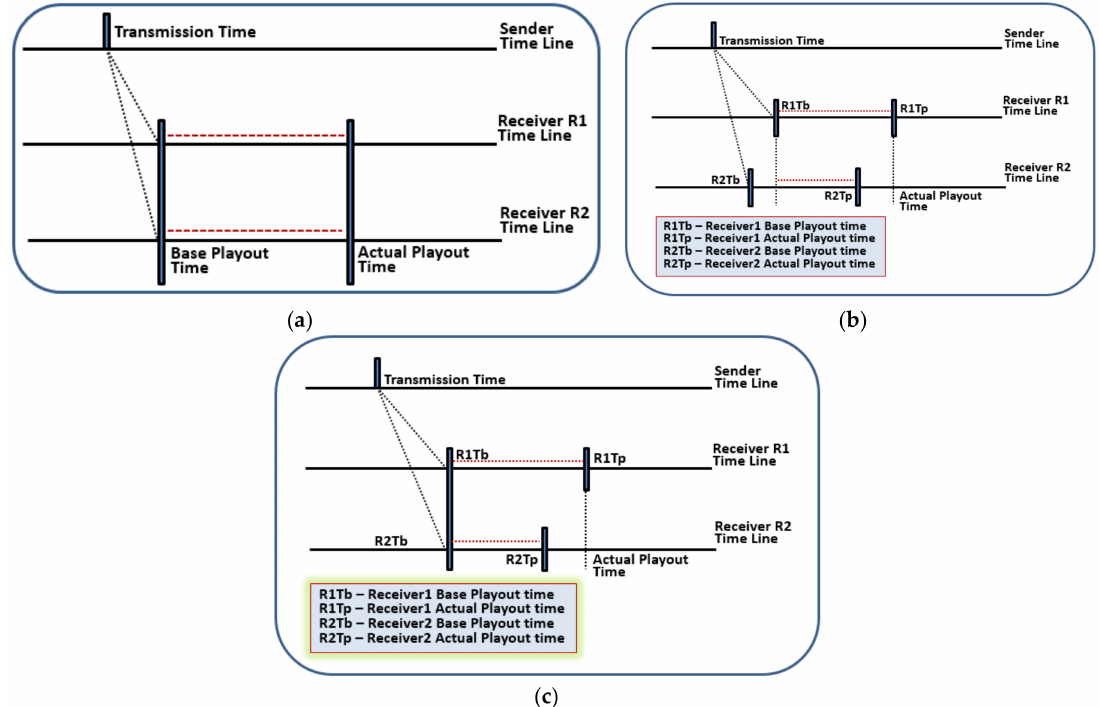
Figure 5. Timeline diagrams showing transmitted and playout time. ( a ) Time line of base and actual playout time of two receivers (R 1 , R 2 ); ( b ) Difference of packet reception at R 1 and R 2 due to receivers locations; ( c ) Timeline showing Synchronizing base playout time of R 1 and R 2